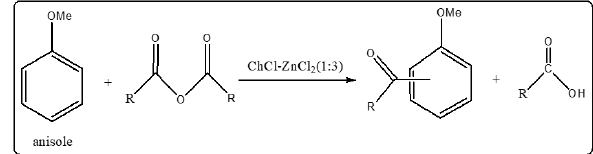
Figure 4: Friedel-Crafts acylation of anisole with respect to acid anhydride catalyzed by ChCl-ZnCl b See Tran et al. [30] for detailed reaction components and